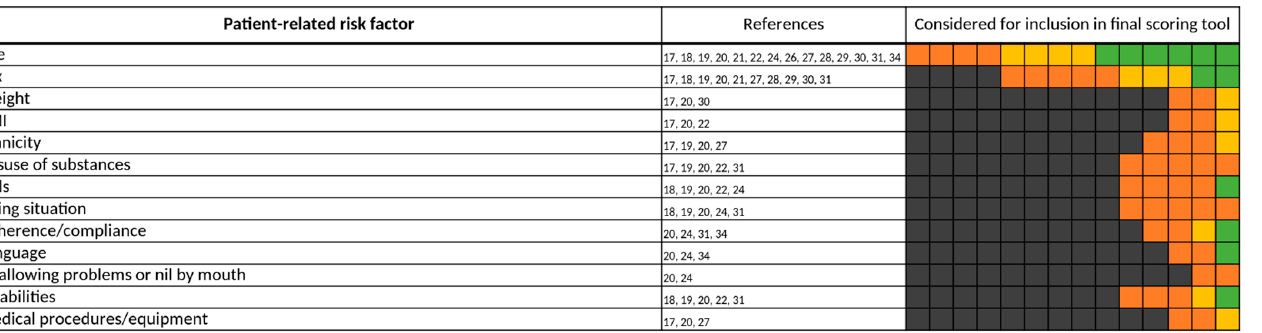
Figure 11. All different thresholds investigated by the authors of the included studies for “age”. Each of the 14 boxes represents one of the included studies. The color of the boxes portrays whether